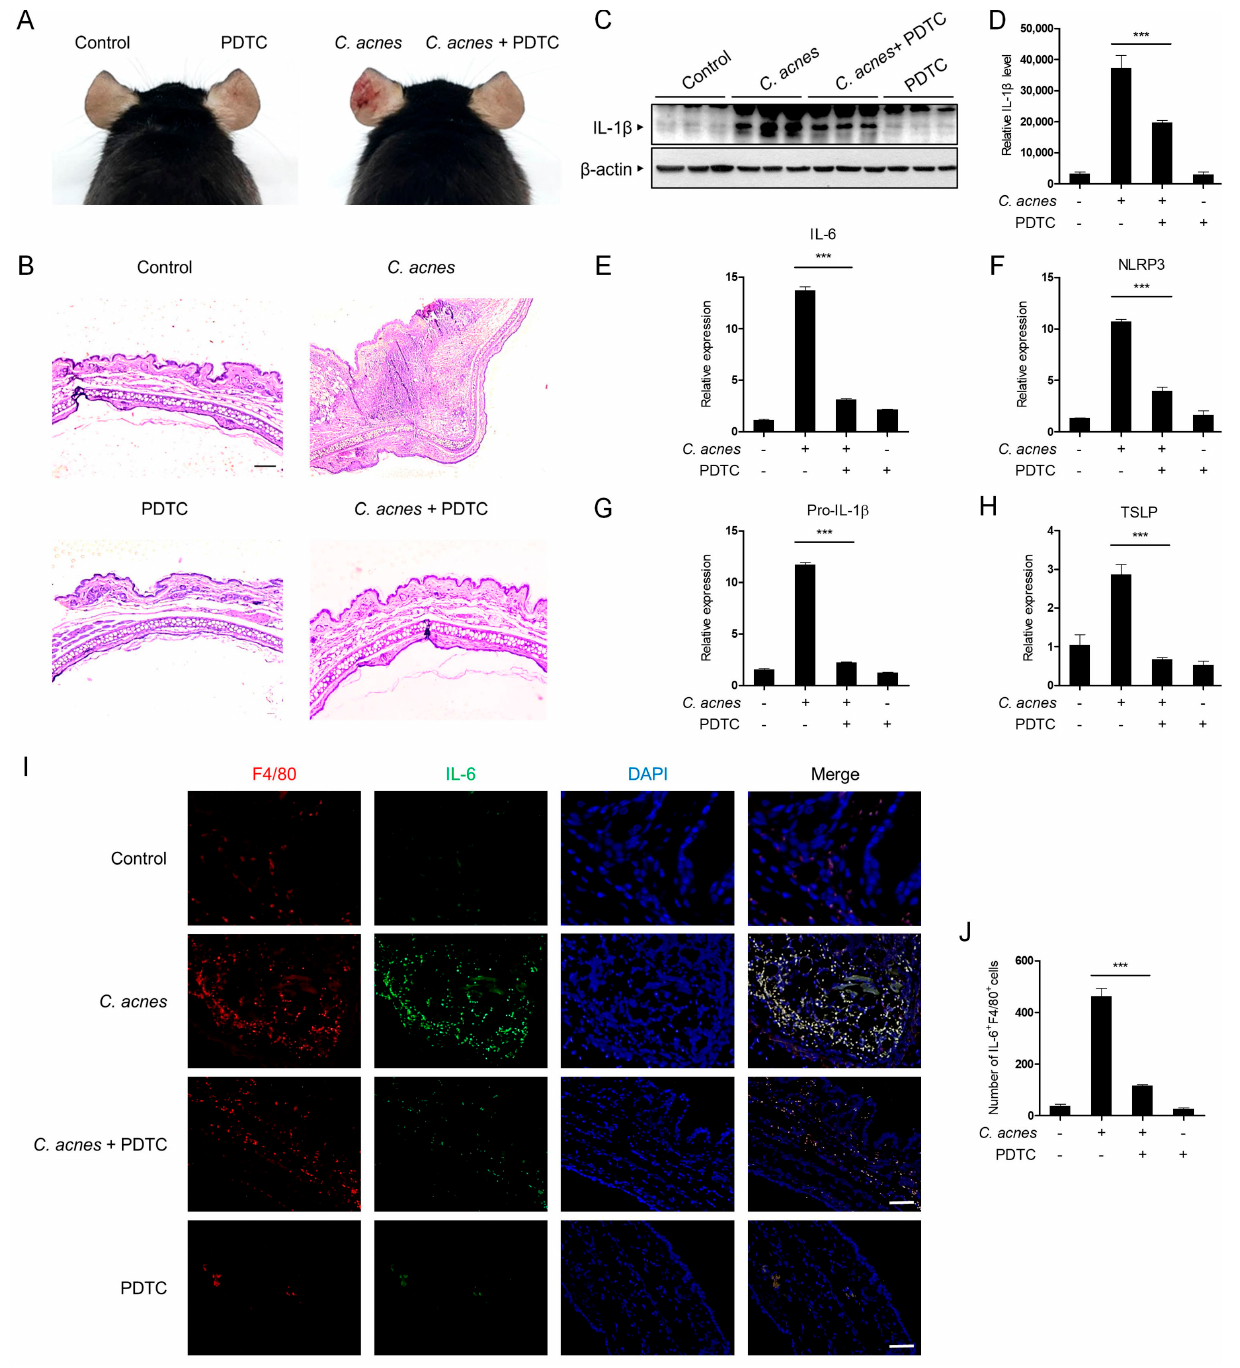
Figure 5. Inhibitory effects of PDTC in a mouse acne model. ( A ) Live C. acnes (1 × 10 8 CFU per 20 μ L in PBS) were injected into mouse ears with or without PDTC (100 mg/kg). At 24 h after injection, mouse ears were photographed. ( B ) Ear tissues were sectioned and stained with H&E. Scale Bars: 100 μ m. ( C ) IL-1 β and β -actin protein levels were detected in ear tissues using Western blot analysis. ( D ) The relative levels of protein bands were quantified. ( E – H ) The mRNA (IL-6, pro-IL-1 β , NLRP3, and TSLP) levels were measured in mouse ear tissues using quantitative real-time PCR. ( I ) Immunofluorescence tissue images were obtained for F4/80 (red) and IL-6 (green) in acne lesions. DAPI (blue) was used to detect nuclei. The images were captured separately and merged. Scale bars: 50 µ m. ( J ) The number of IL-6 + F4/80 + cells in the image was counted. The results are represented as the means ± SDs of three independent experiments. *** p <